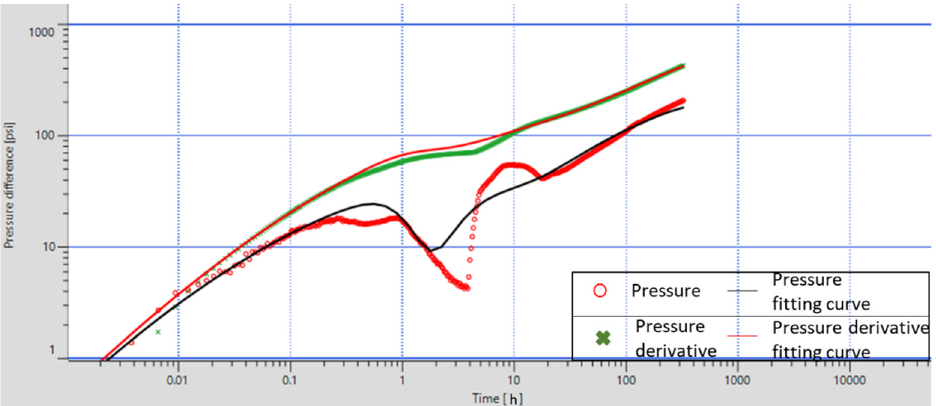
Figure 19. 8 ‐ 5H well test curve. Figure 19. 8-5H well test